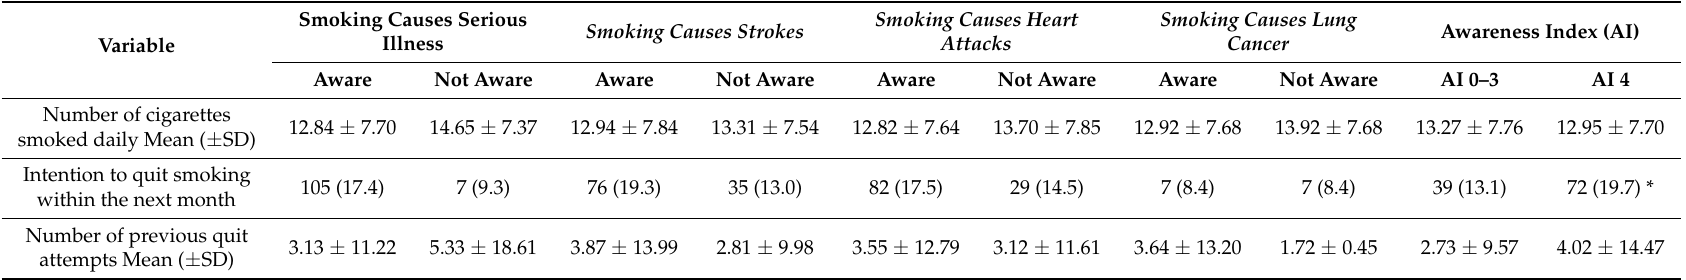
Table 3. Awareness Index (AI) in relation to the number of cigarettes smoked daily, number of previous quitting attempts and intention to quit smoking within the next